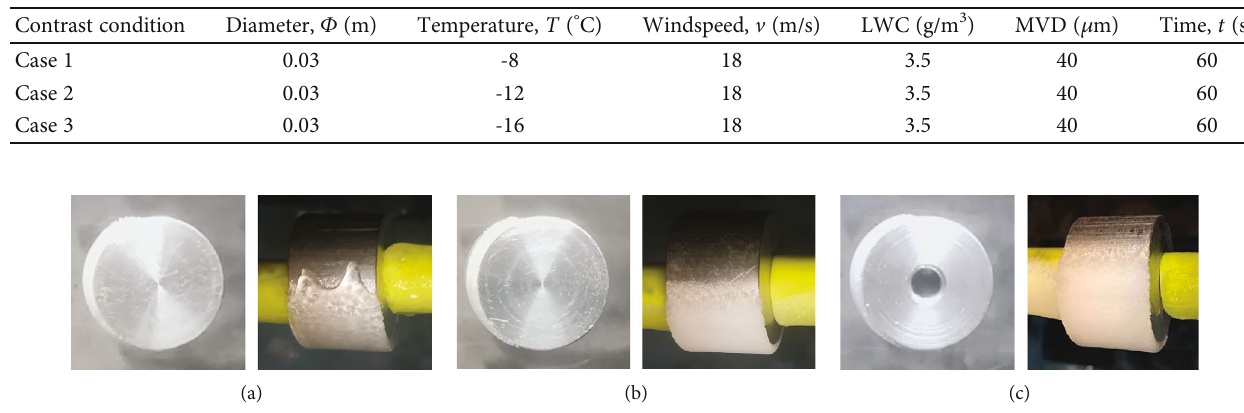
Table 1: Cylindrical icing